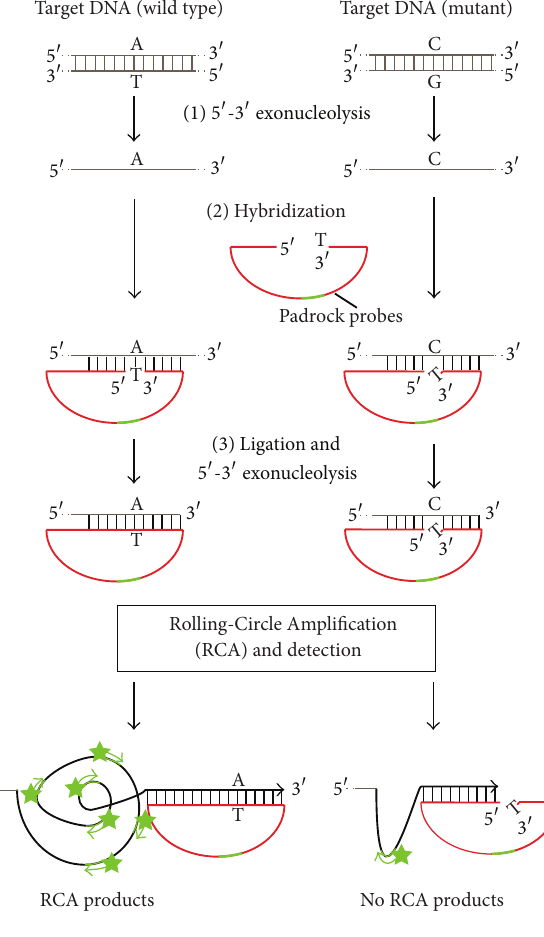
Figure 6: Schematic representation of the target-primed Rolling- Circle Amplification (RCA) of circularized padlock probes. (1) 5 󸀠 –3 󸀠 exonucleolysis: the target DNA is restriction digested 3 󸀠 of the target sequence and irreversibly made single stranded by strand-specific 5 󸀠 –3 󸀠 exonucleolysis. (2) Hybridization: padlock probes (red) with the tag sequence (green) are hybridized to their target sequences. (3) Ligation & 5 󸀠 –3 󸀠 exonucleolysis: adjacent padlock probes that are perfectly complementary to the target (left) are connected by DNA ligase, thus locking the probe onto the target molecule. After ligation, the RCA is initiated by the Phi29 DNA polymerase, by turning the target molecule into a primer through the 3 󸀠 –5 󸀠 exonucleolysis of any 3 󸀠 end protruding beyond the padlock probe hybridization site. The padlock probe then serves as the template for DNA synthesis. The RCA product (black) is detected through the hybridization of fluorescently labeled probes (green) to tag sequences specific for the padlock probe. Arrowheads indicate 3 󸀠 ends of the RCA